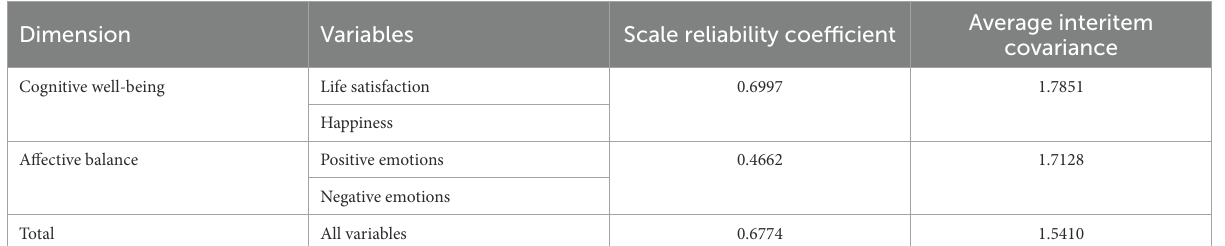
TABLE 3 Alpha reliability, subjective well-being variables and dimensions.